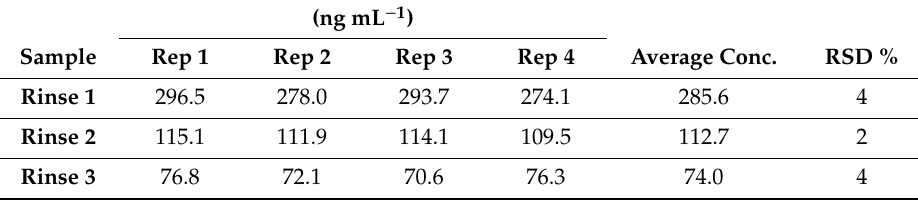
Table 4. Dicamba quantification from 500 mL water samples. Conc., concentration.